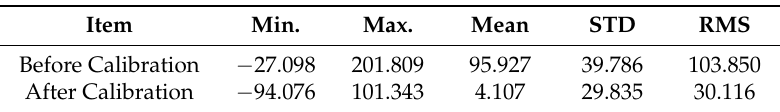
Figure 12. Statistical plot of the elevation error. The peaks are at 120 m and 0 m respectively, before and after calibration. Statistical plot tends to a more standard normal distribution after calibration.